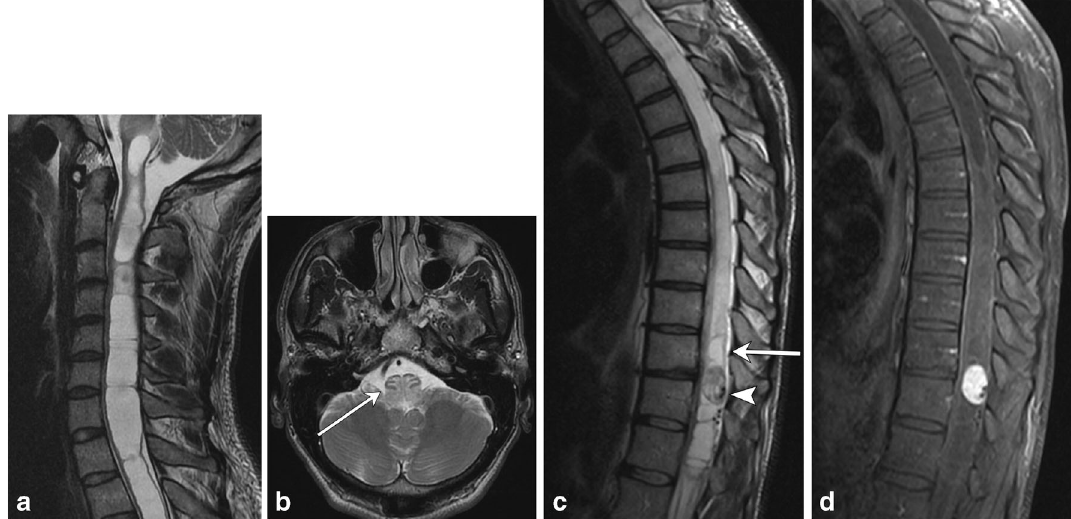
Fig. 14 Hemangioblastoma. A 40-year-old male with neck spasms and gait disturbance. a and b Spinal cord syrinx involving the entirety of the cervical cord extends superiorly to the cervicomedullary junction, where there is mass effect on the brainstem with resulting edema (arrow); there- fore, more inferior spine imaging was obtained to look for the cause. c